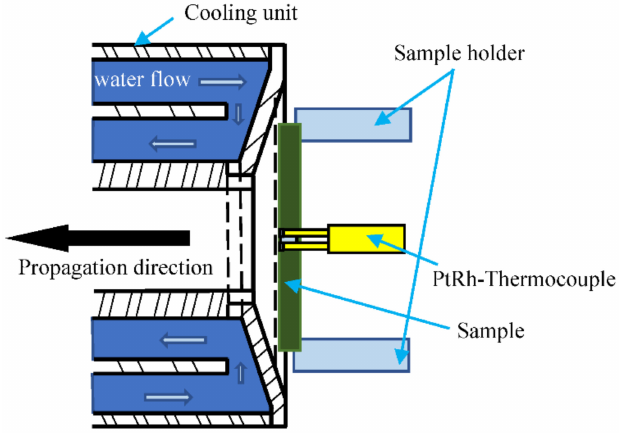
Figure 17. Schematic diagram of the device made by the SiC tube as the sample heating cavity [75].